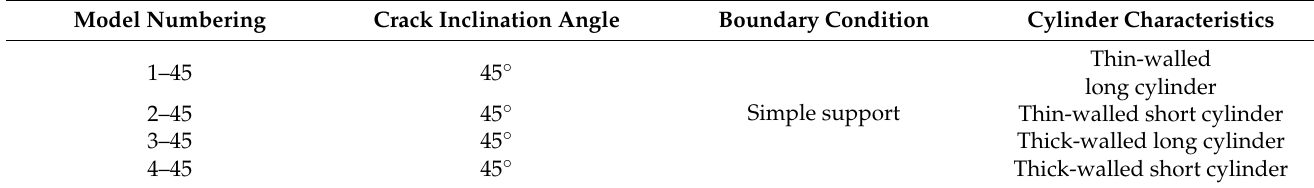
Table 2. The Parameter of